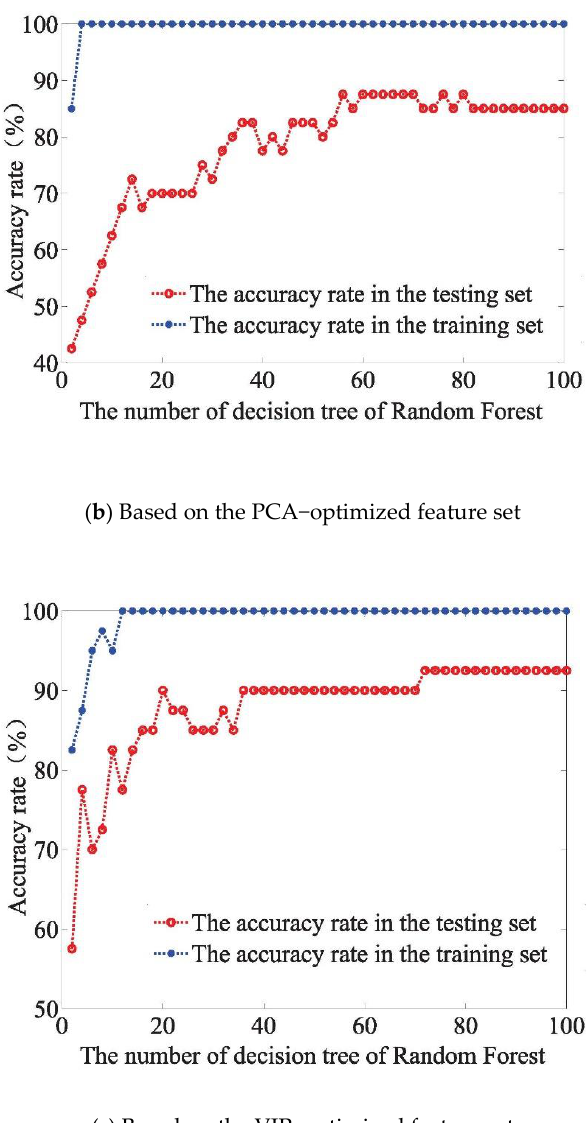
Figure 9. Classification performance of RF network based on decision trees.